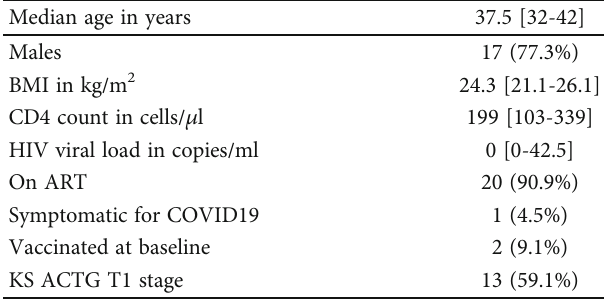
Table 1: Baseline characteristics of study